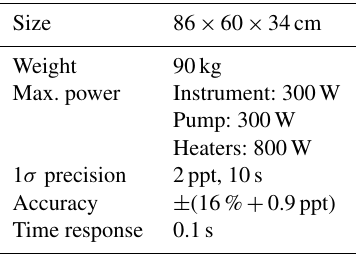
Figure 13. Data from final descent on 28 October in the range 12– 17km. Left panel: 10s average SO 2 mixing ratios plotted against the bottom axis. 2Hz O 3 plotted against the top axis. Right panel: 10s averages of SO 2 plotted against O 3 . Table 1. Performance and physical specifications for operation of the SO 2 instrument, the NASA